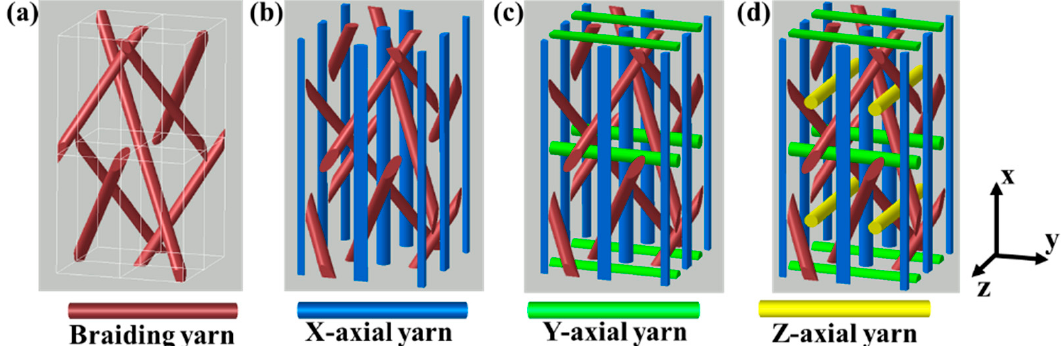
Figure 2. Meso ‐ structures of ( a ) 3D4d, ( b ) 3D5d, ( c ) 3D6d and ( d ) 3D7d braided composites. Repro ‐ duced with permission from [10]. Copyright 2020 Elsevier.